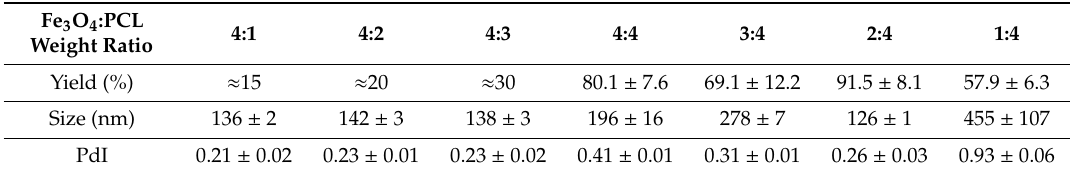
Table 1. Yield (%), and size (nm) and PdI of the Fe 3 O 4 / PCL NPs for the relative weight proportions of Fe 3 O 4 and PCL ranging from 4:1 to